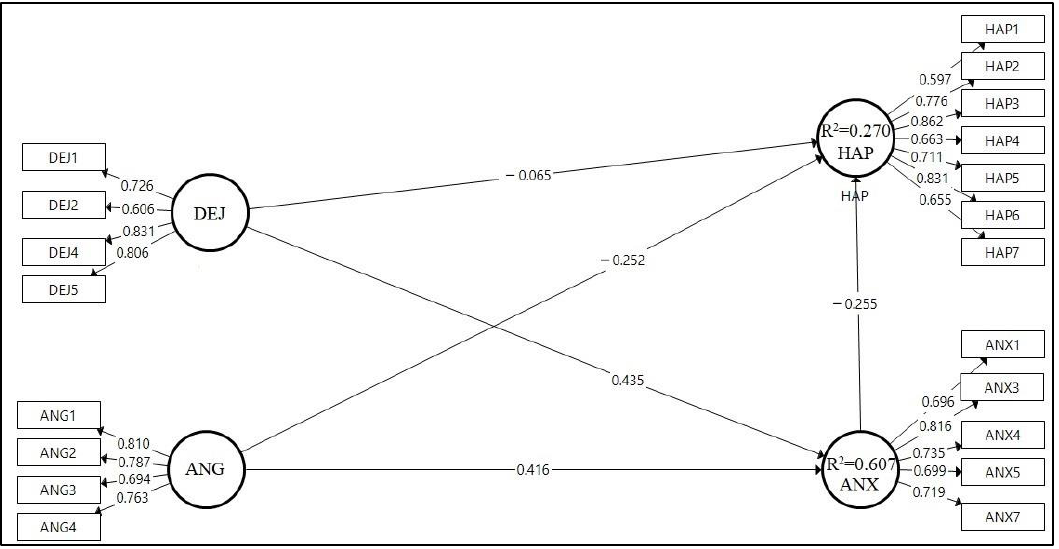
Figure 5. Final structural model with standardized path coefficients.